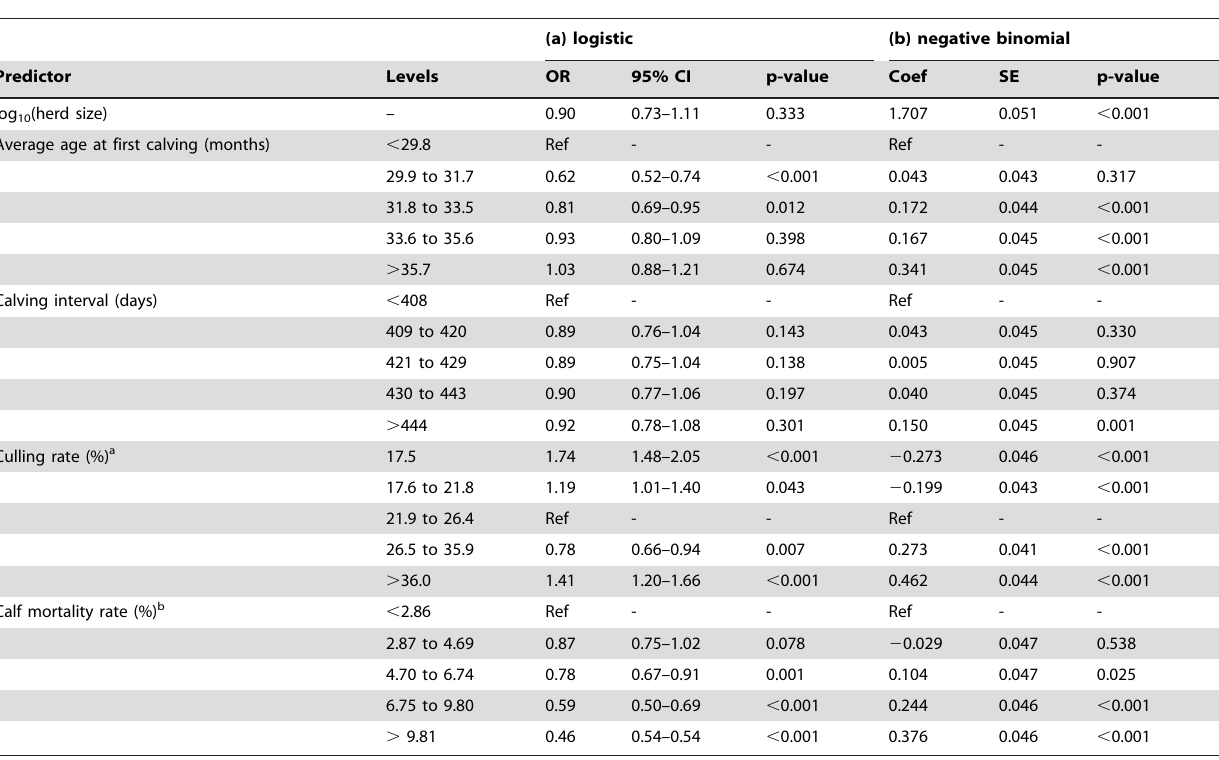
Table 2. Zero-inflated negative binomial regression model for dairyherds.